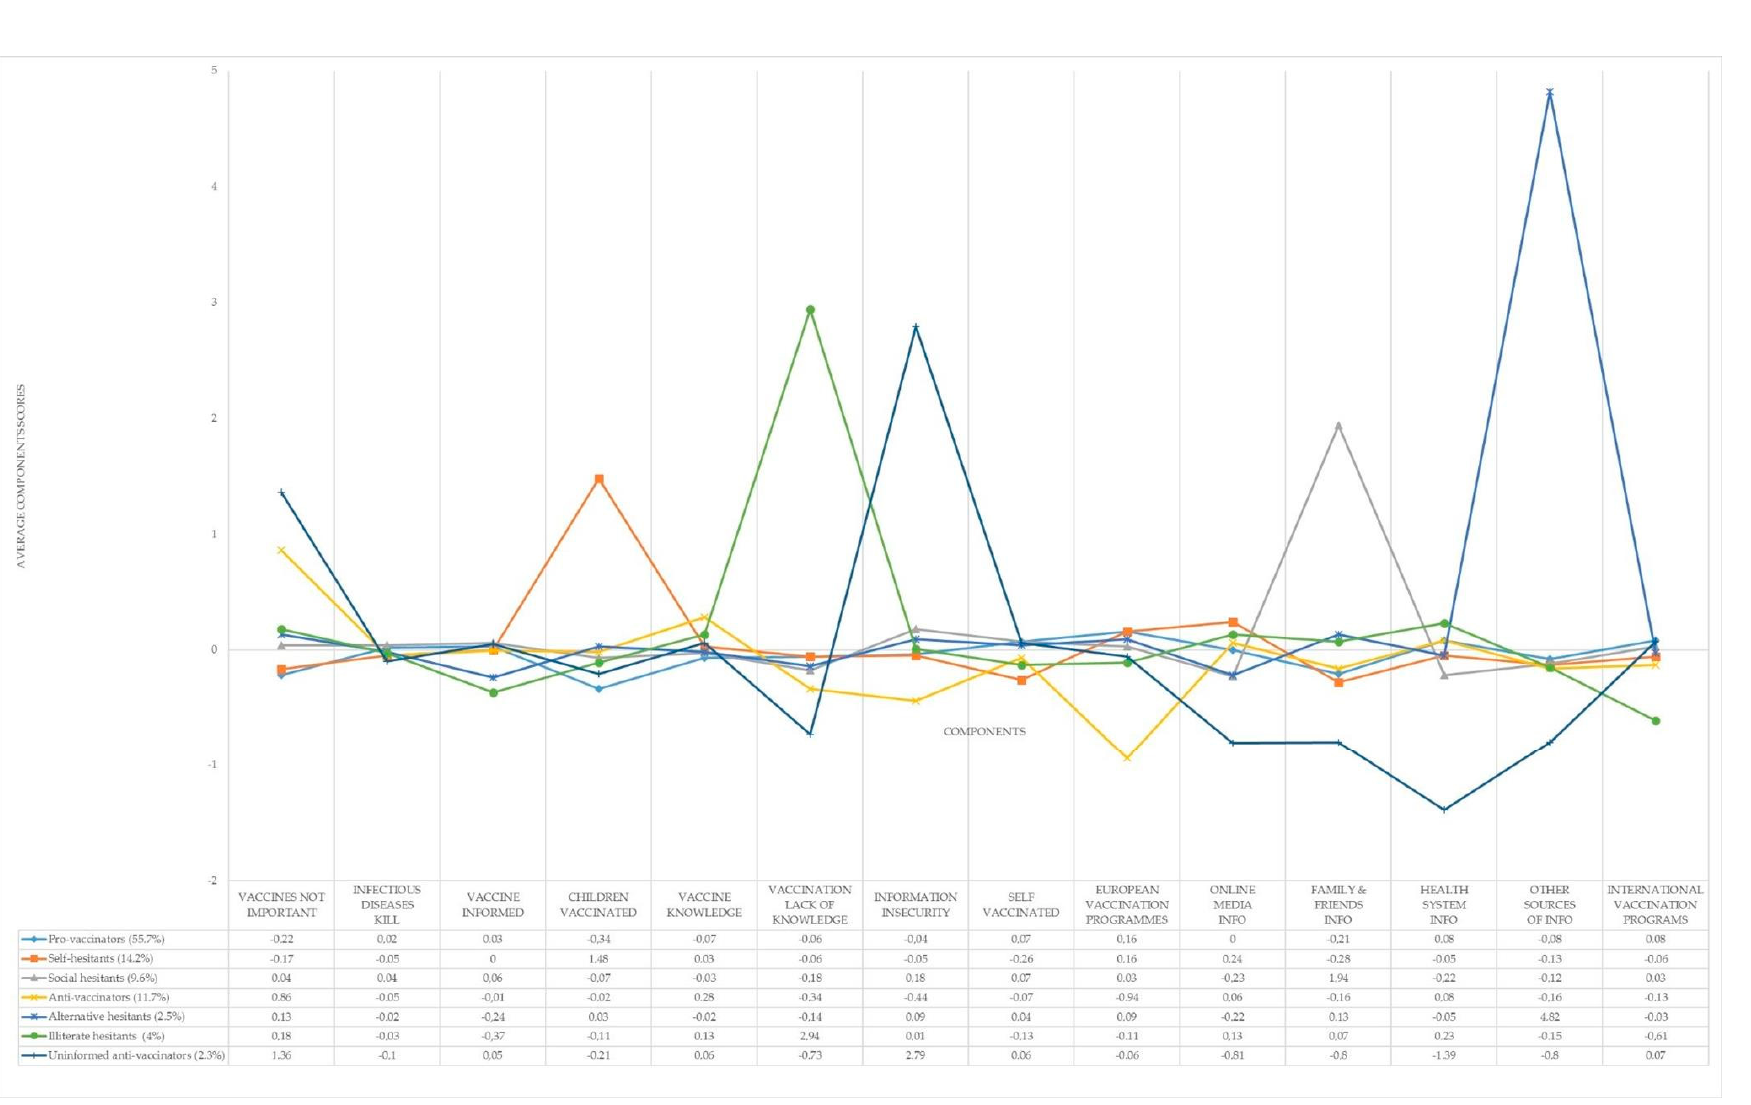
Figure 1. European sentiments towards vaccines. Behavioral segments profile.